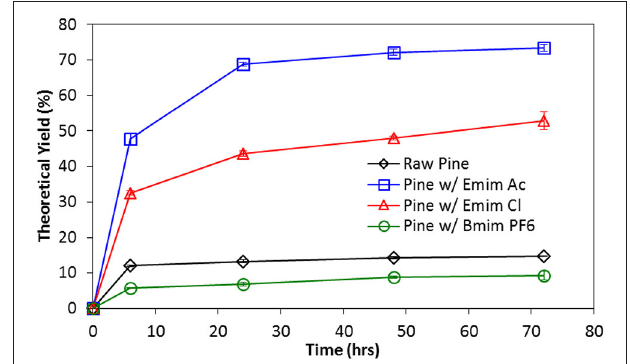
FIGURE 3 | Enzymatic hydrolysis of lodgepole pine. Theoretical sugar yield is the sum of glucan, xylan, galactose, arabinose, mannose, and cellobiose released divided by the sugars in the pretreated